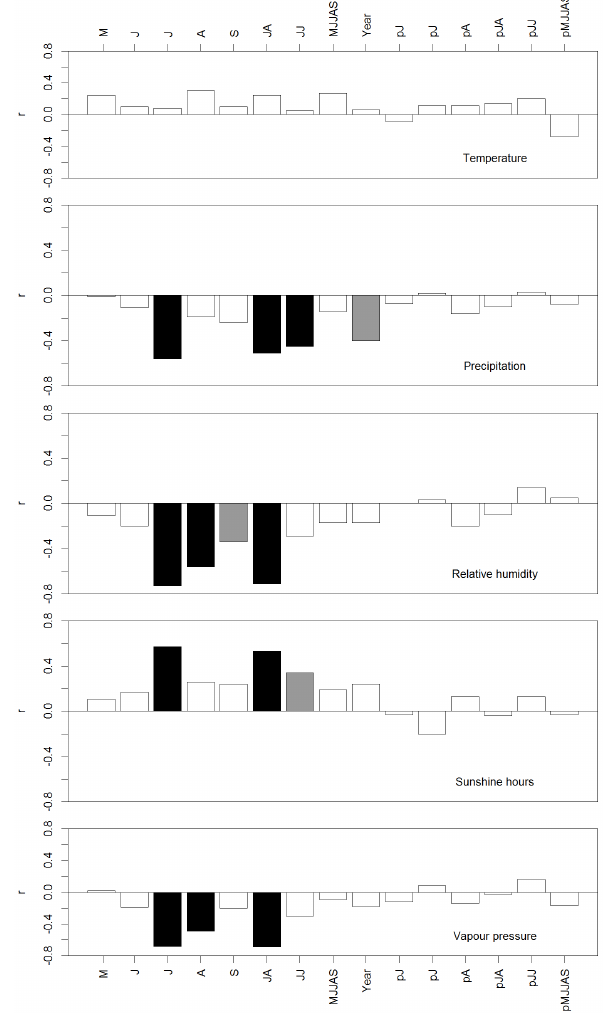
Figure 3. Response of tree-ring δ 18 O to monthly/seasonal temper- ature, precipitation, relative humidity, sunshine hours, and vapour pressure over the period AD1956–1996. Gray and black bars indi- cate correlations significant at p< 0 . 05 and p< 0 . 01, respectively; p indicates months/seasons of the previous